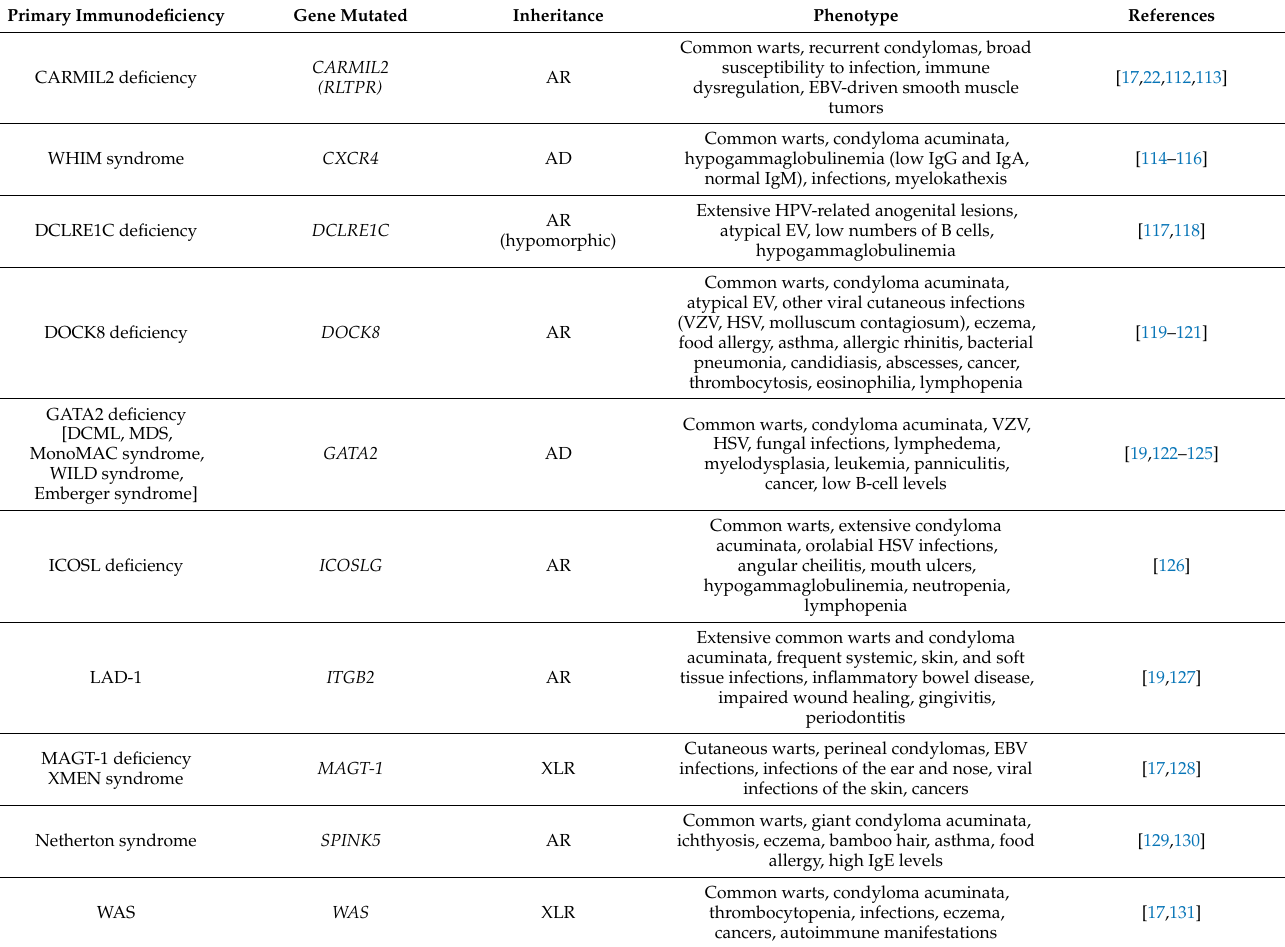
Table 1. Primary immunodeficiencies associated with extensive condyloma